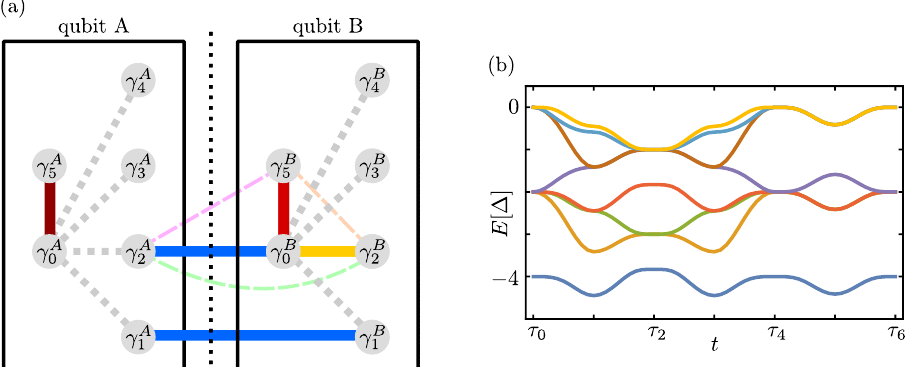
Figure 3: (a) Sketch of the two-qubit system, with constraints on the single-qubit parities imposed by a finite H (black rectangles). The intra-qubit couplings P A and E 05 P B which are non-vanishing in the idle configuration are highlighted with dark red 05 and red lines, respectively. The double tunneling protocol requires the additional control of the intra-qubit coupling P B (yellow line) and of the inter-qubit couplings 02 I and I (blue lines). Possible parasitic couplings I , I and P B are shown with 20 11 25 22 02 dashed purple, green and orange lines, respectively. (b) Spectrum of the Hamiltonian H dt ( t ) along the closed loop Γ . Only negative energies are shown. Each line is 4-fold = Θ = E = Θ . We considered the six key degenerate. Energies are in units of Θ x x − τ = T / configurations to be equally spaced in time, i.e. τ j + 1 j